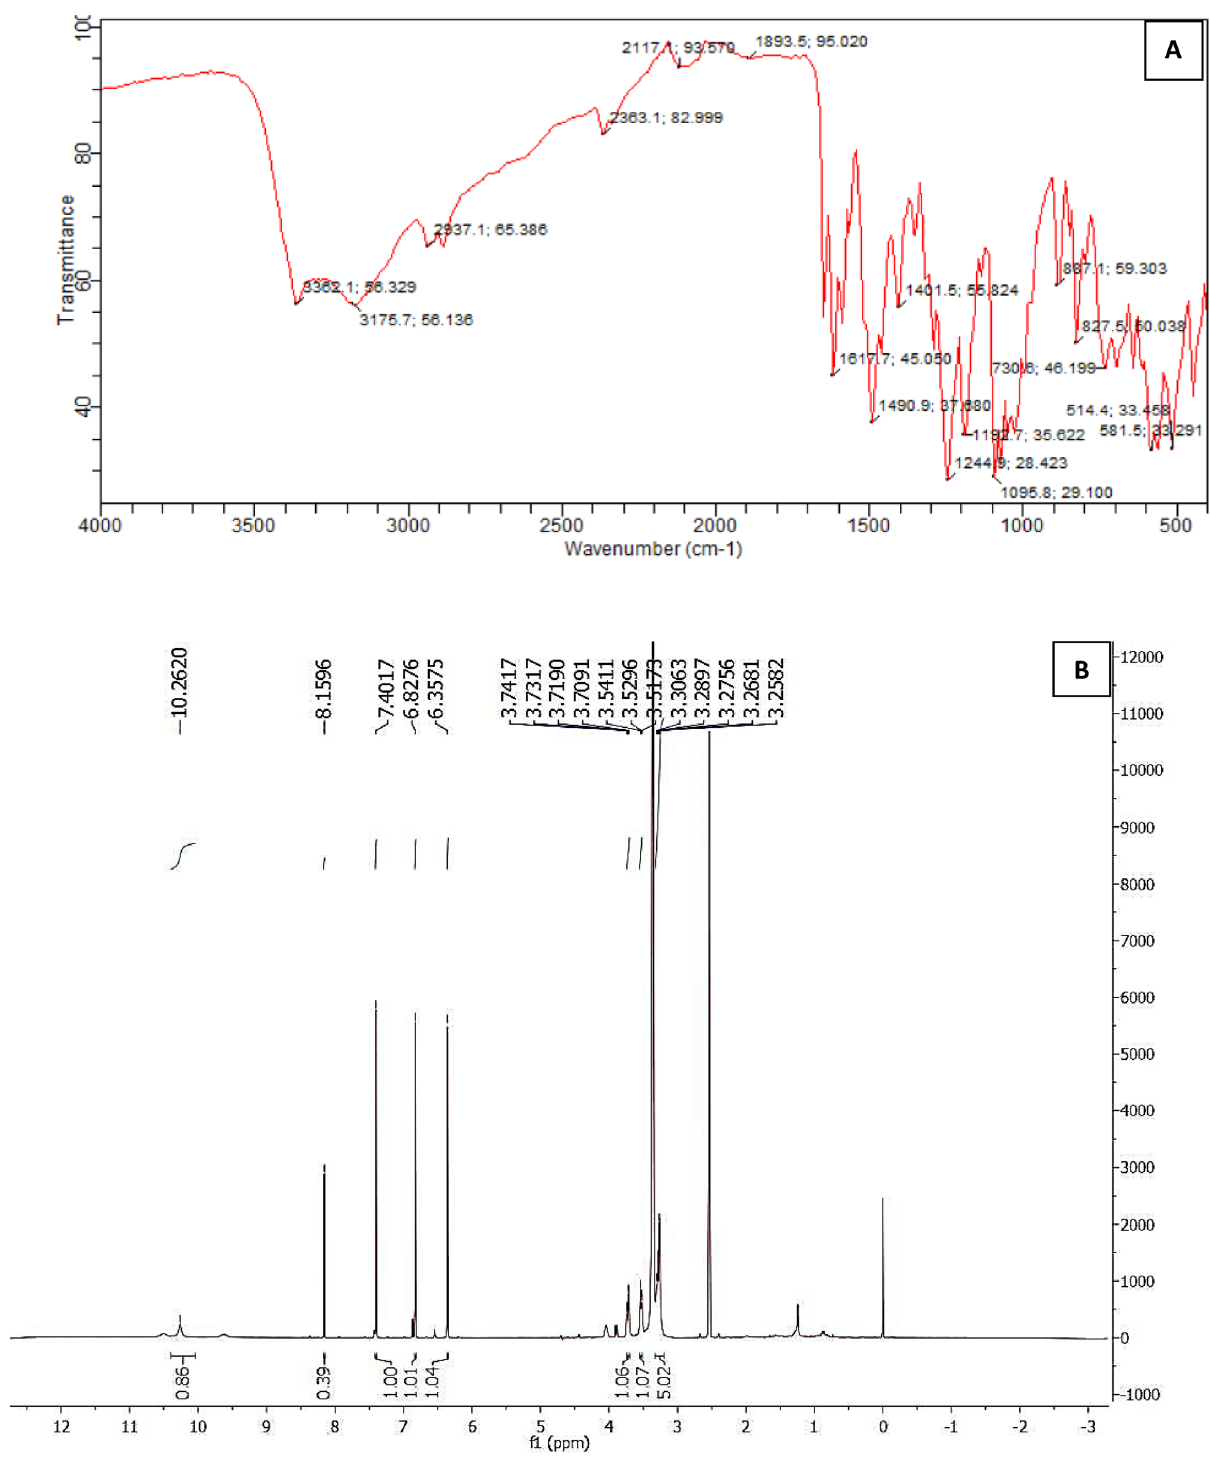
Figure 2. Characterization of isolated mangiferin fraction (F1) through IR ( A ) and 13 C NMR ( B